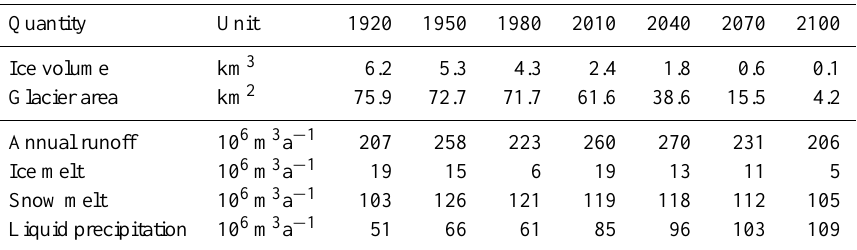
Fig. 10. The different ice-thickness distributions: (a) the GPR-based ice volume distribution, (b) the ice-thickness distribution derived by ITEM, and (c) the uniform ice-thickness distribution. (d) and (e) refer to the ice-thickness difference to the reference distribution determined by measurements. Table 5. Summary of the main results of this study. The evolution of the ice volume, the glacierized area, the annual runoff and the different components of water input to the runoff routing model (ice melt, snowmelt, and liquid precipitation) is shown for the period 1920–2100 in 30-yr steps. Values are averaged over ±